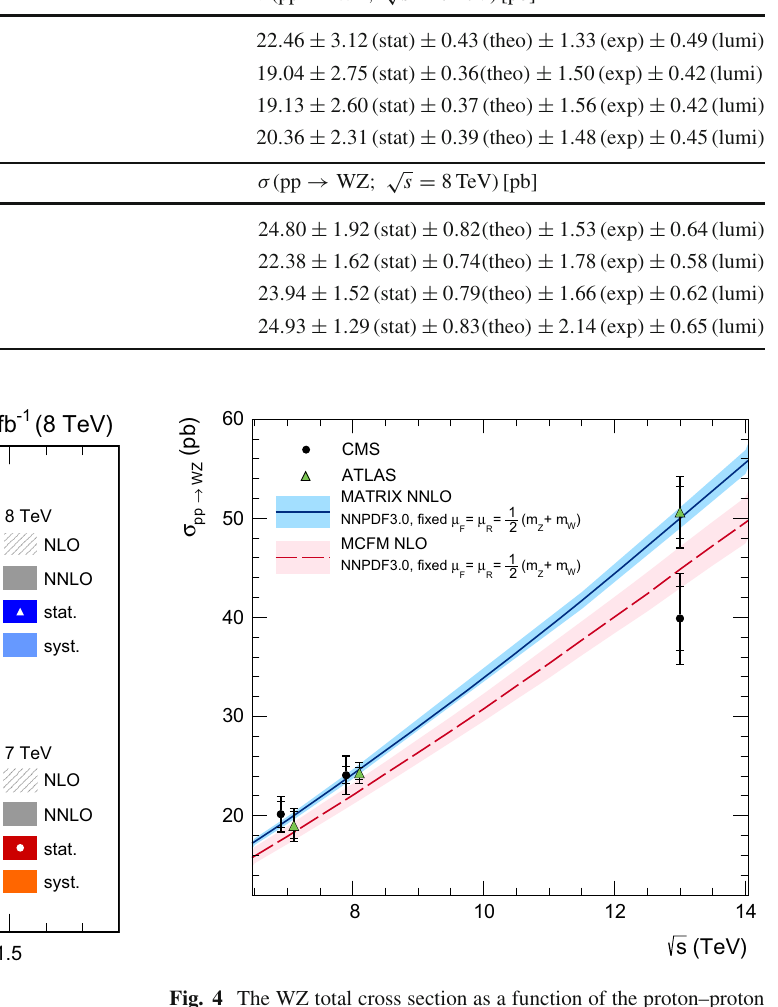
Fig. 4 The WZ total cross section as a function of the proton–proton centre-of-mass energy. Results from the CMS and ATLAS experiments arecomparedtothepredictionsofMCFMand Matrix .Thedatauncer- tainties are statistical ( inner bars ) and statistical plus systematic added inquadrature( outerbars ).Theuncertaintiescoveredbythebandaround the theoretical predictions are described in the text. The theoretical pre- dictions and the CMS 13TeV cross section are calculated for the Z boson mass window 60–120GeV. The CMS 7 and 8TeV cross sections presented in this paper are calculated for the Z boson mass window 71– 111GeV (estimated correction factor 2%), while all ATLAS measure- ments are performed with the Z boson mass window 66–116GeV (1%) function of three different observables: the Z boson p T , the number of jets produced in association with the (cid:5)ν(cid:5) (cid:5) (cid:5) (cid:5) final state, and the p T of the leading accompanying jet. For